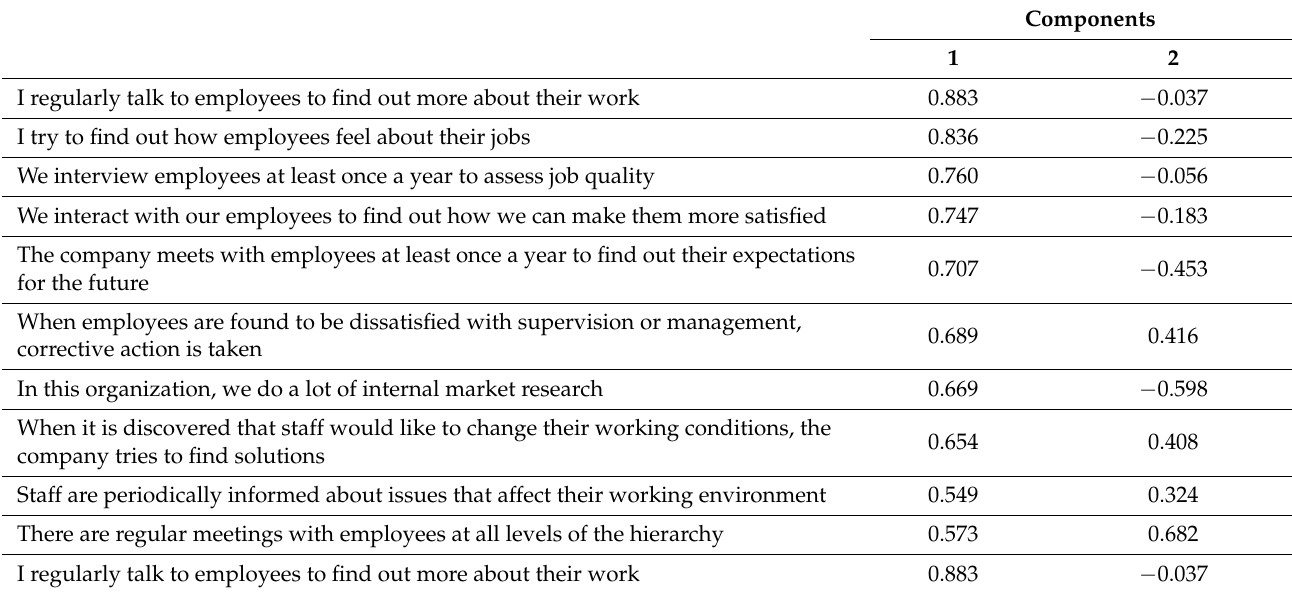
Table 13. Component matrix before